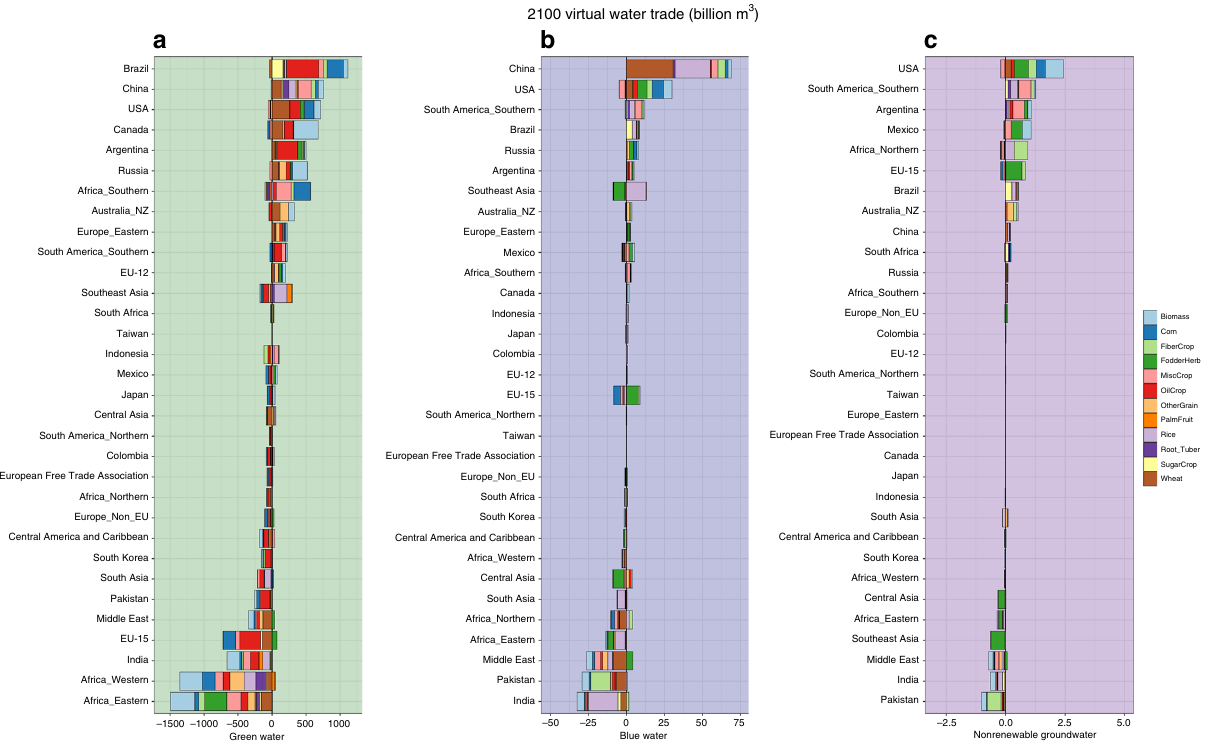
Fig. 2 Virtual water trade fl uxes by water type, region, and crop in 2100. a Average global virtual green water trade (billion m 3 ), b virtual blue water trade (billion m 3 ), and c virtual nonrenewable groundwater trade (billion m 3 ) by crop and aggregate GCAM region in 2100 for all SSP2-RCP6.0 GCM scenarios ( n = 5). Positive values represent exports while negative values imply virtual water